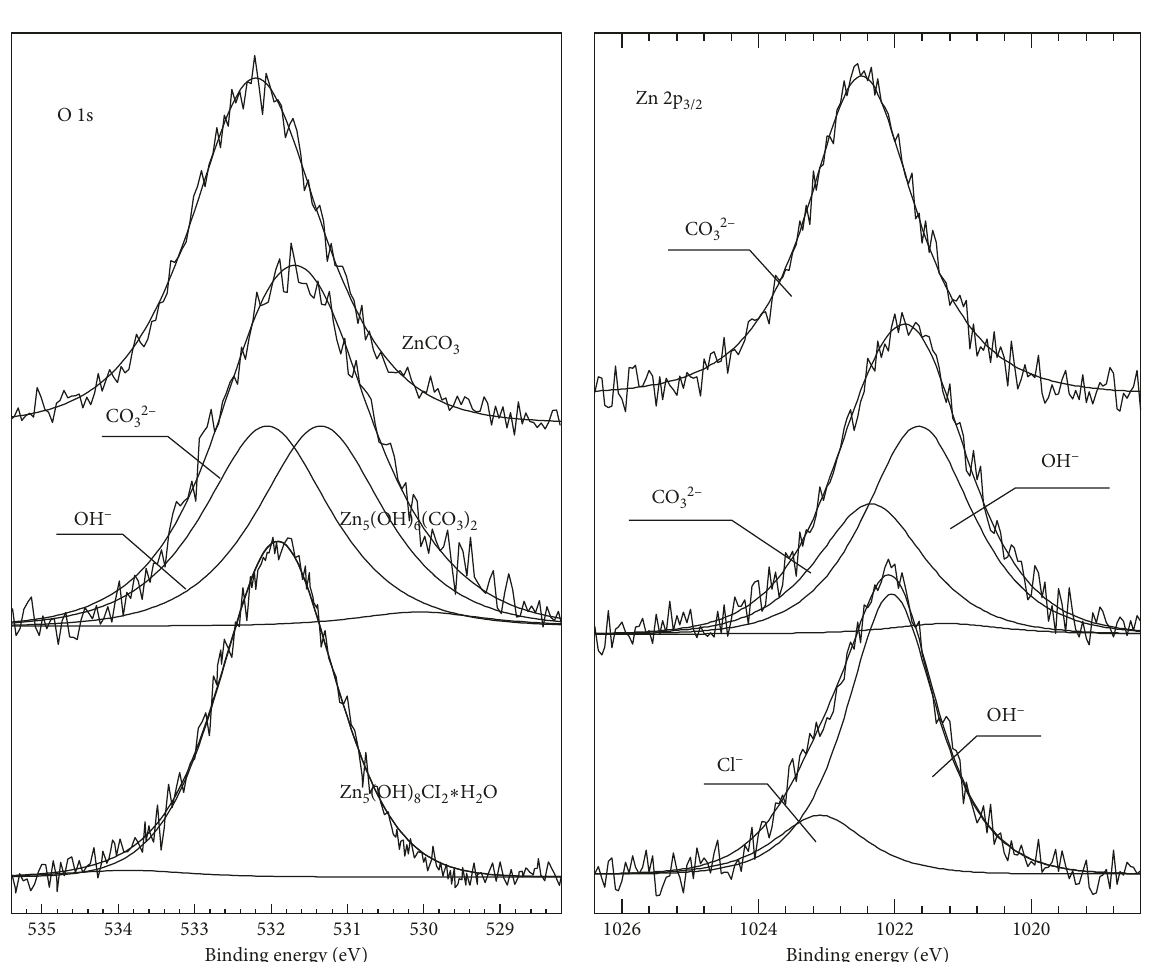
Figure 7: O 1s and Zn 2p